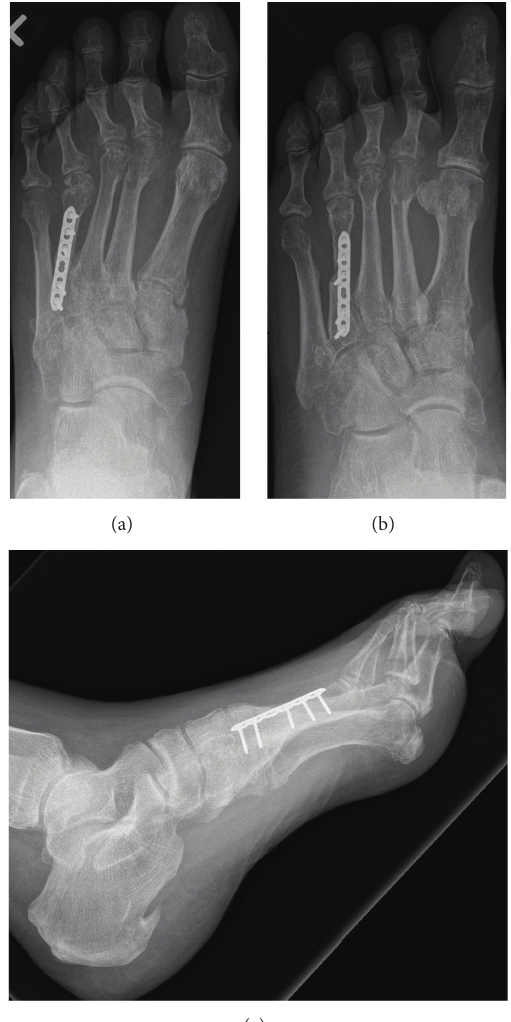
Figure 4: Final dorsoplantar (a), oblique (b), and lateral (c) radiographsshowingfusionatfracturesite,shorteningoffourthMT, and maintained reduction at the fourth MTP